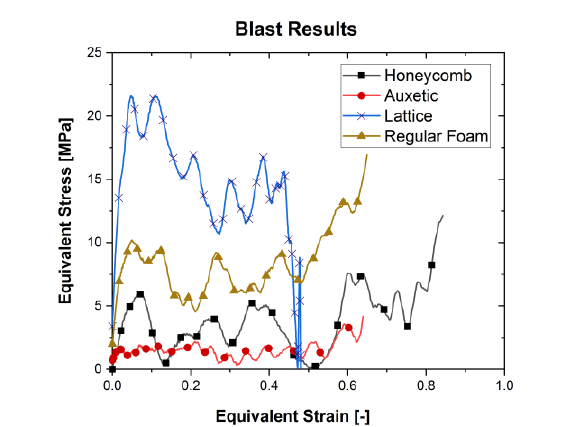
Fig. 3 . The experimental blast results for the tested structures of Honeycomb, Auxetic, Lattice and Foam, performed by means of the EDST with 30g of the C4 explosive charge.